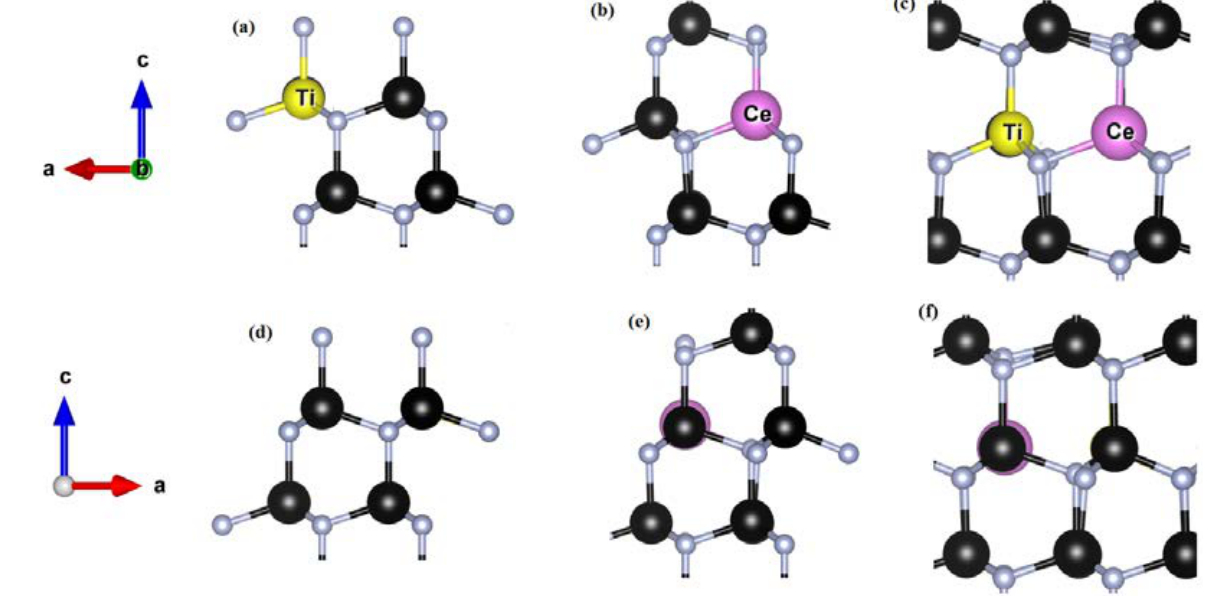
Figure 2. Local geometry of ( a ) Ti Ga ( b ) Ce Ga ( c ) Ti Ga -Ce Ga in GaN after complete relaxation of respective structures. ( d – f ) shows 180° rotated structures to view the structures from the backside. Black and gray spheres represent Ga and N atoms, respectively, whereas the dopant atoms Ti and Ce are already mentioned. Direction indicator showing a-, b- and c-axis is given.